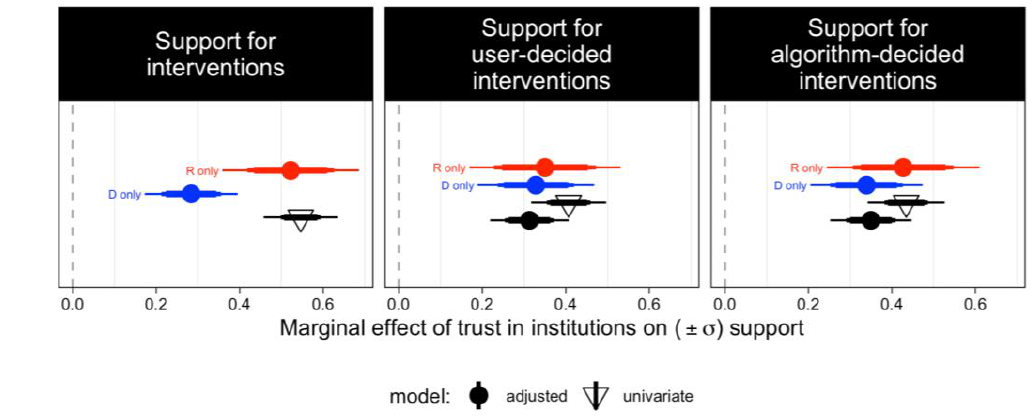
Figure 7. Association between institutional trust and support for specific interventions. This plot shows how a standardized increase in institutional trust predicts an increase in support ( x -axis) for the overall intervention support index as well as different categories of intervention sources (panels) amongst all respondents (black), as well as Republicans only (red) and Democrats only (blue). From our battery of questions, user-decided interventions are the following intervention sources (listed in Figure 6): users the respondent knows, a diverse group of volunteer users, or a politically moderate group of volunteer users. See the Methods section for the control variables used in the adjusted